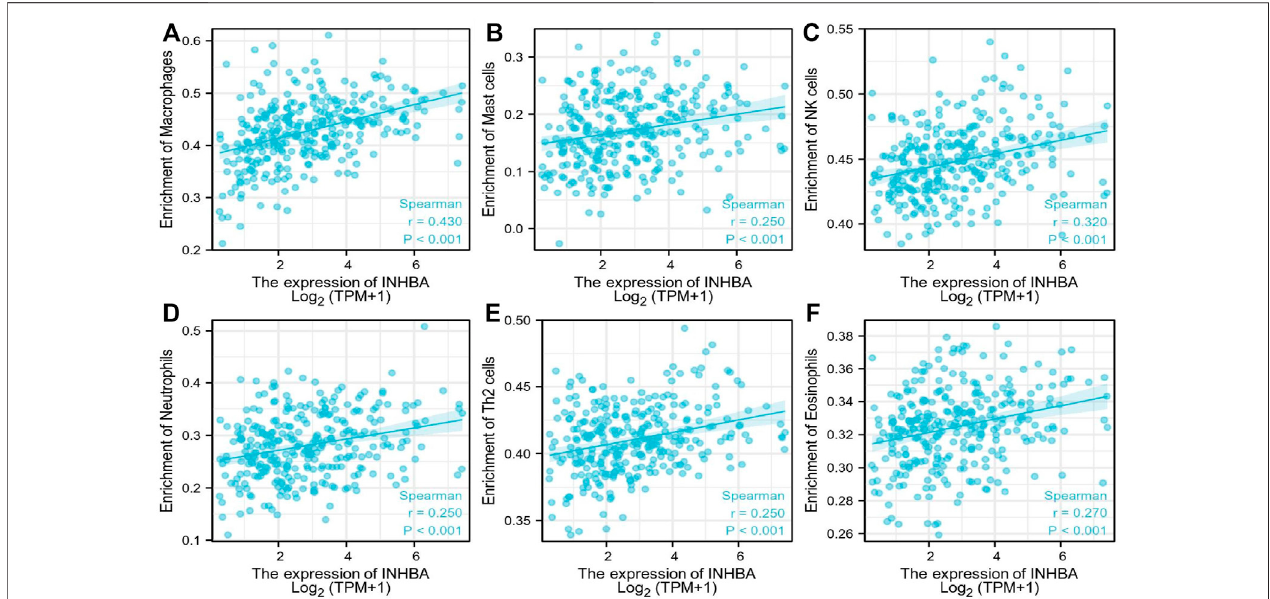
Frontiers in Genetics |